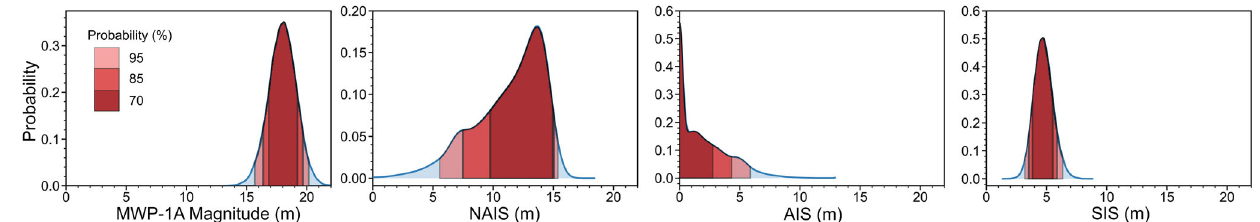
Fig. 5 Sea-level oscillation limit constrained inversion results. Each panel shows a probability density function of the averaged inversion result of the empirical and uniform scenarios associated with total MWP-1A magnitude or the contribution from each ice sheet. Shaded areas indicate 95/85/70%